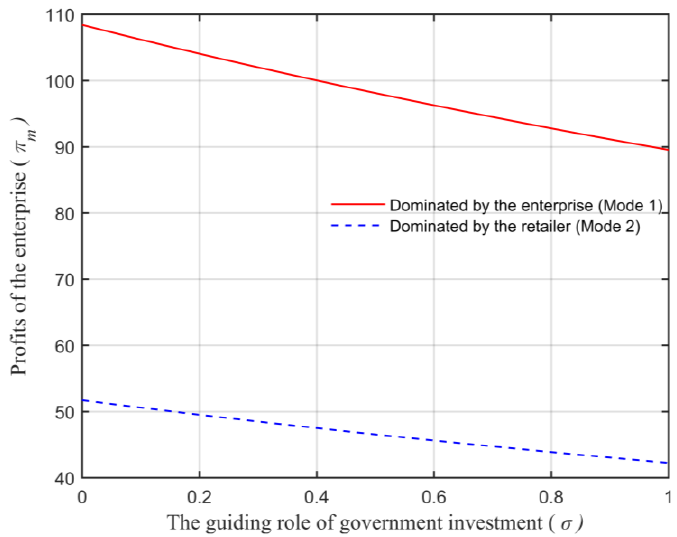
Figure 10. The relationship between the guiding role of government investment and the marine ranching leading enterprise’s profits.